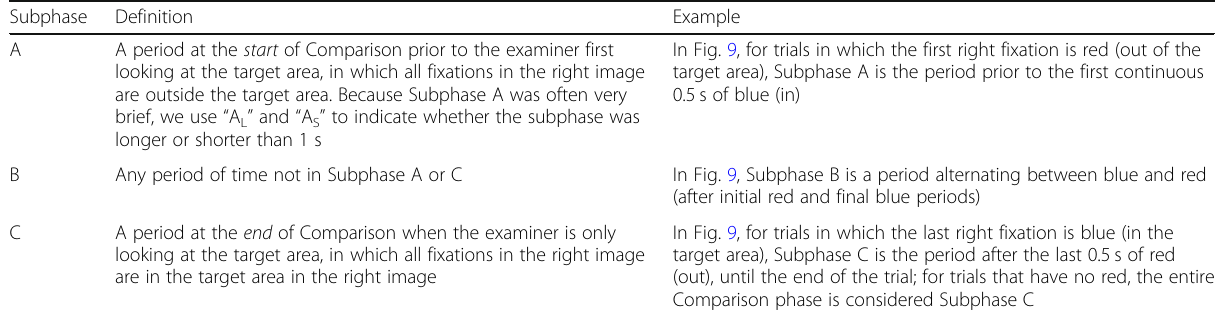
Table 1 Definitions of subphases of trials